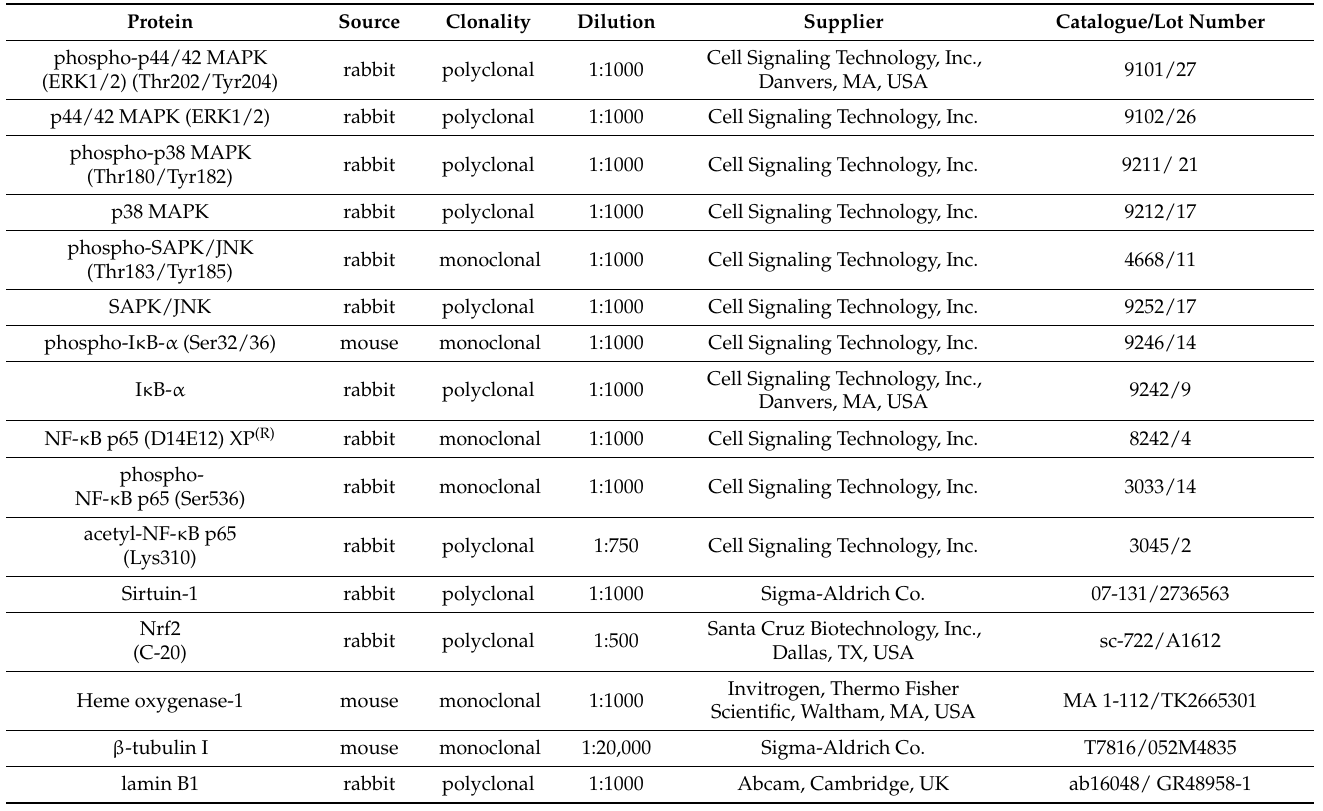
Table 1. List of primary antibodies used in Western